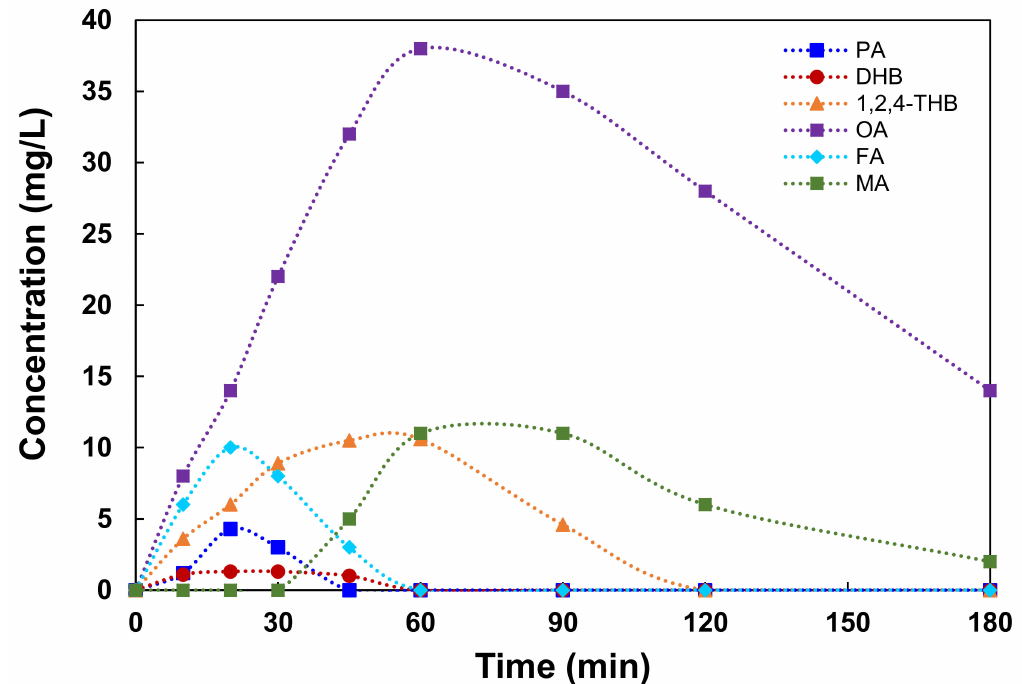
Figure 9. Evolution of the concentration of aromatic and aliphatic intermediates detected during the Fenton degradation of aqueous solution containing 100 ppm DAP. Experimental conditions: [DAP] 0 = 100 mg/L; [H 2 O 2 ] = 1000 mg/L; [Fe 2+ ] = 50 mg/L; pH =